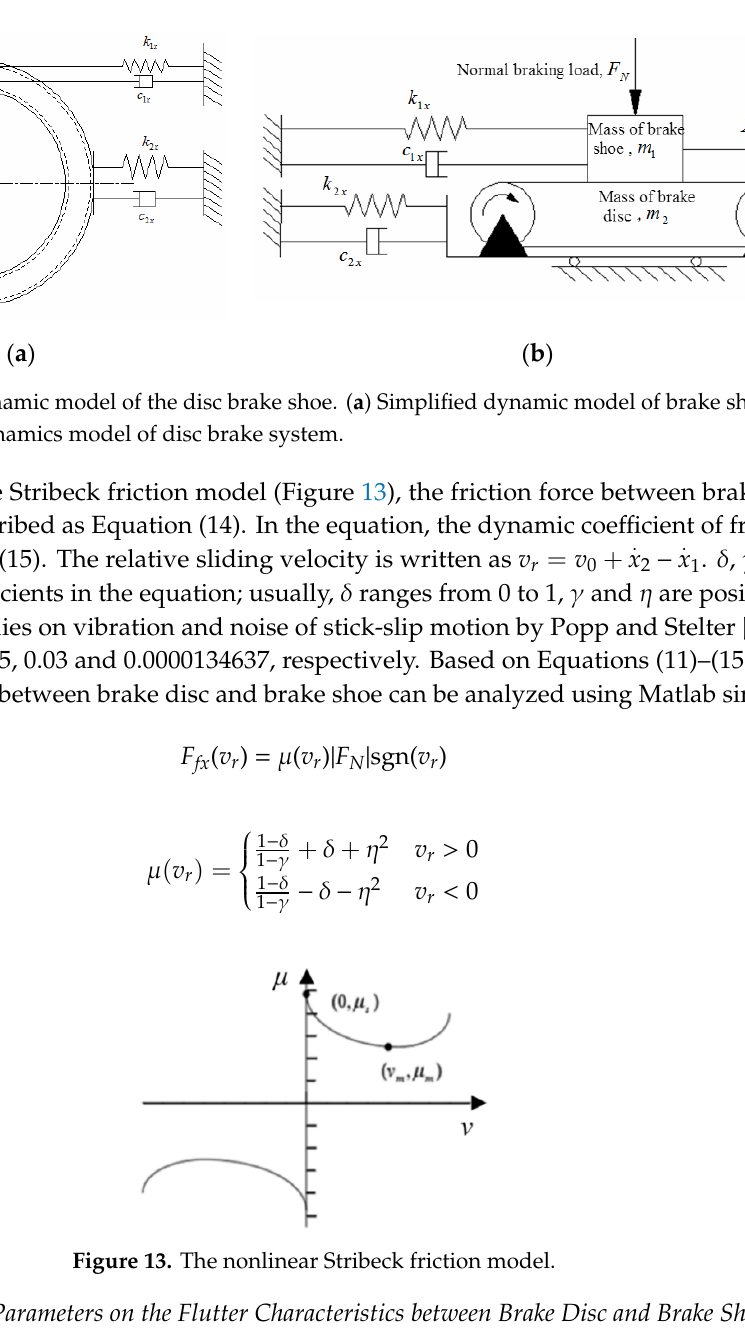
The simulation parameters are: k 1 = 1 N / m, k 2 = 1 N / m, c 1 = 0.1 N · s / m, c 2 = 0.1 N · s / m, m 1 = 0.035 kg, m 2 = 2.959 kg and N = 10 N [12]. In order to explore the e ff ect of initial braking speed on